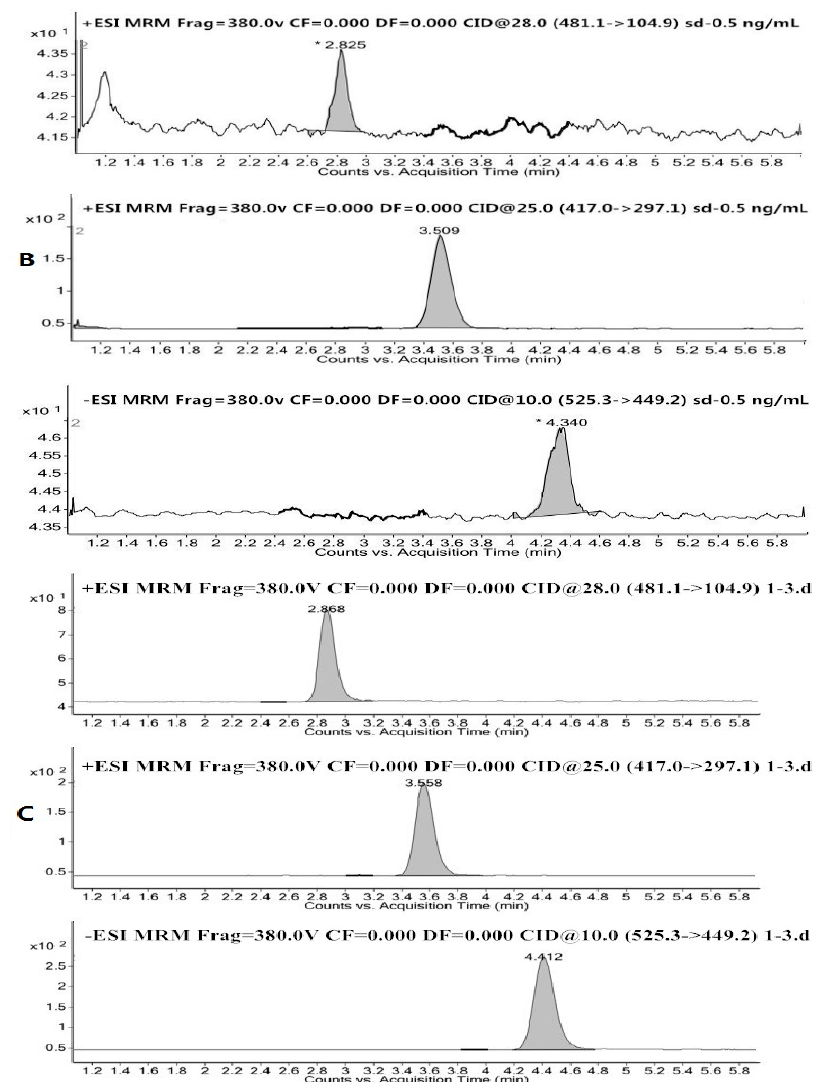
Figure 2. Representative MRM chromatography of a blank plasma ( A ); a blank plasma spiked with albiflorin (2.82 min), paeoniflorin (4.34 min) and the IS (3.50 min) of LLOQ ( B ); and rat plasma sample collected at 0.5 hour after administration ( C ).